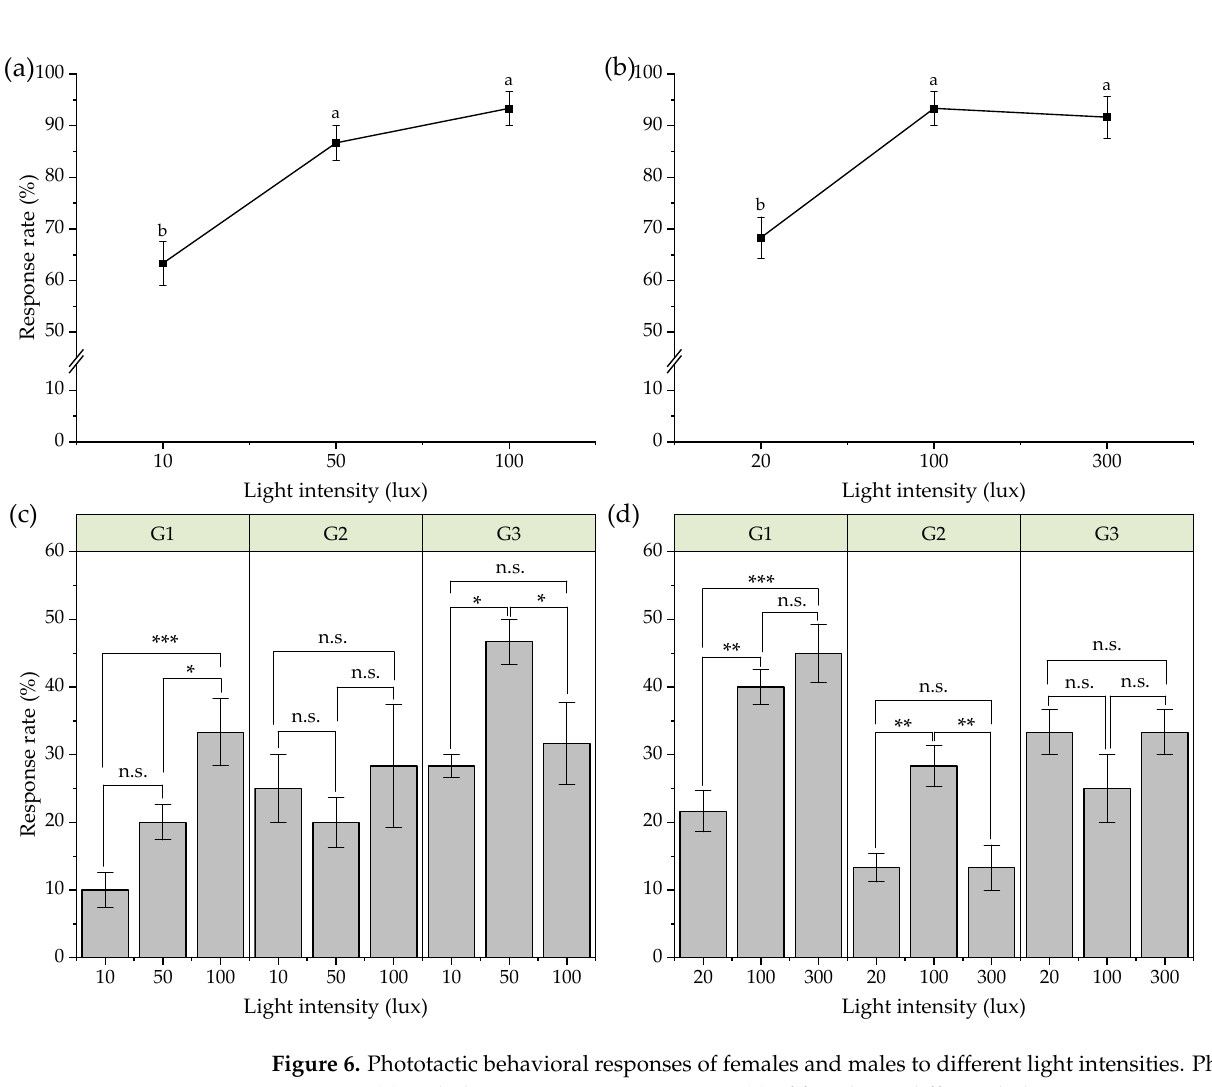
Figure 5. Correlation analysis between light intensity and phototactic response rate of adults. ( a ) females; ( b ) males. * significant at p < 0.05 level,** significant at p < 0.01 level, *** significant at p < 0.001 level by Pearson correlation analysis.